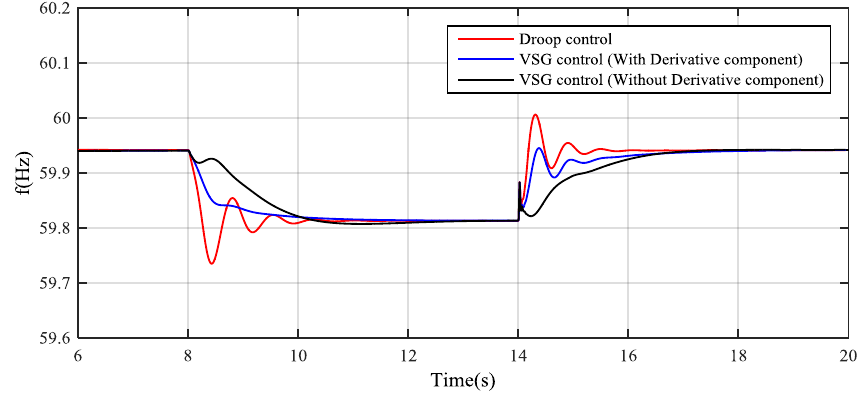
Figure 14. System frequency.